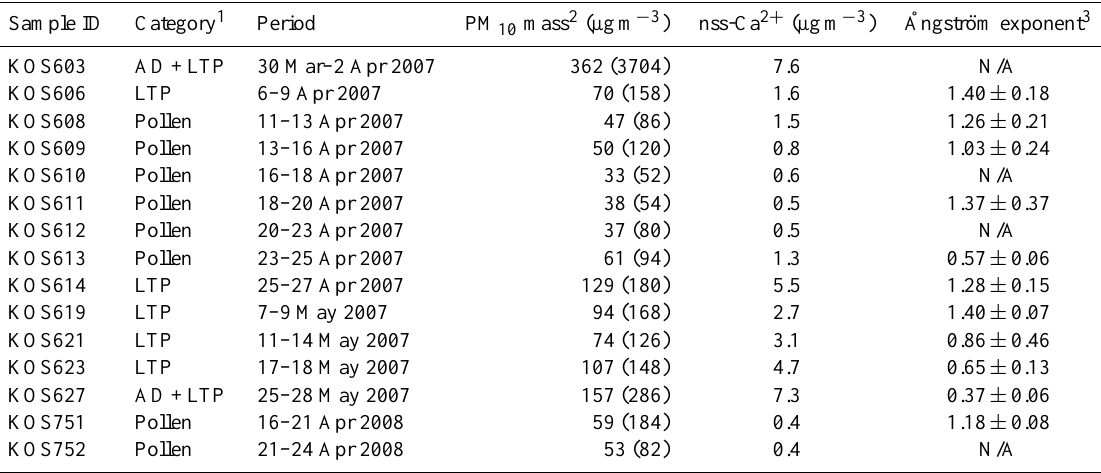
Table 1. Specifics of sampling, PM 10 mass concentration, non-sea-salt calcium ion (nss-Ca 2 + ), and ˚Angstr¨om exponent at the Gosan site during the carbon episodes in spring of 2007 and 2008.